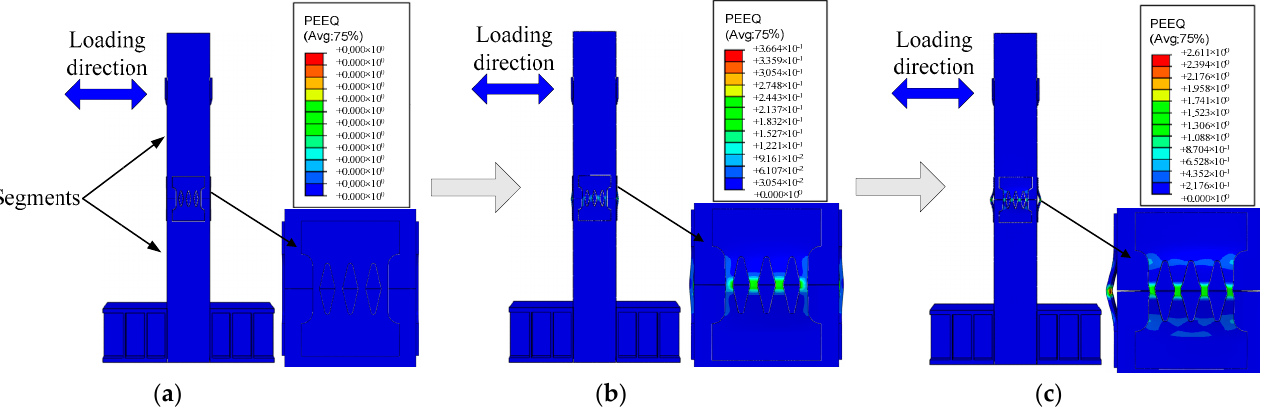
Figure 12. Deformation of specimen R0 during loading; ( a ) Prophase; ( b ) Metaphase; ( c ) 𝛿 = 4% .